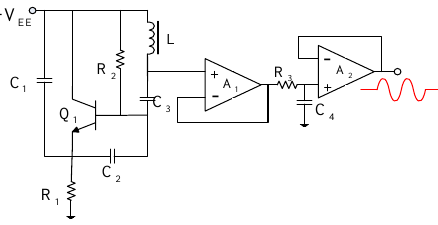
Figure 9. A Clapp oscillator as the driving excitation. The oscillation frequency is 2.3 MHz, and the oscillation amplitude is about 1 V.